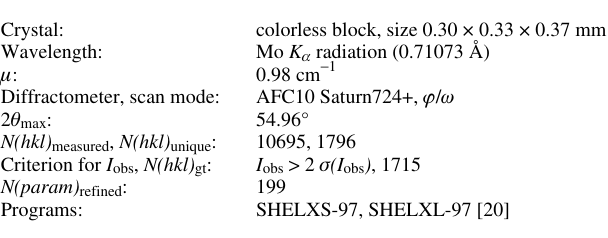
Table 1. Data collection and handling.